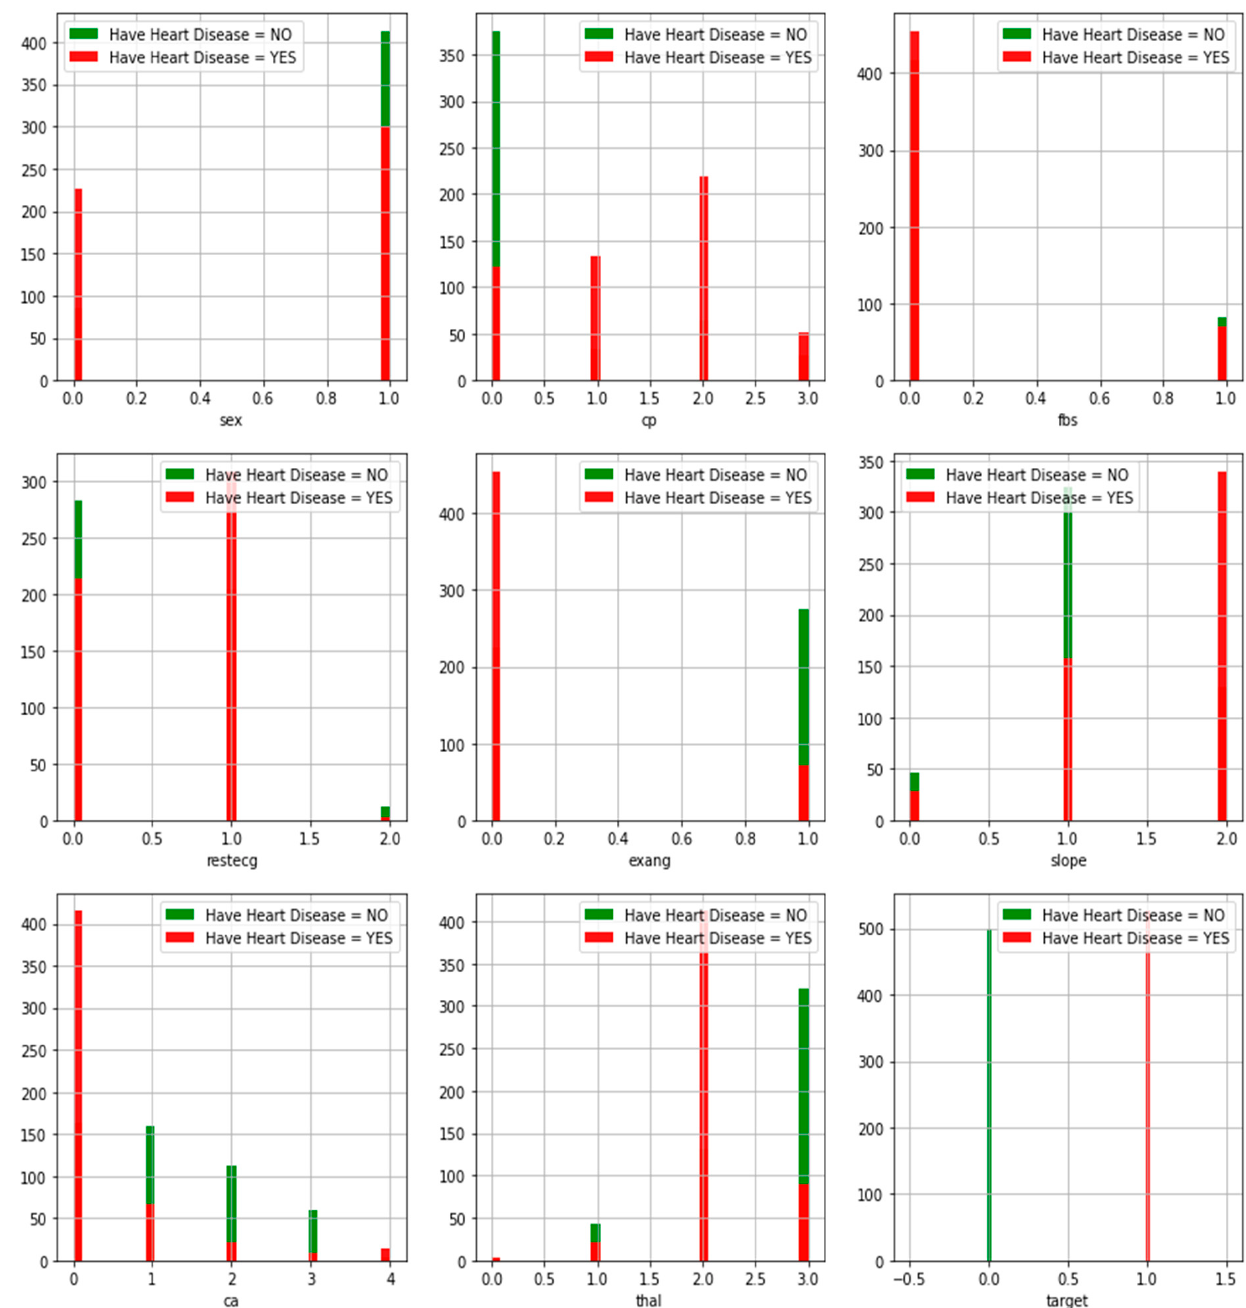
Figure 3. The histograms of characteristics with categorical values.